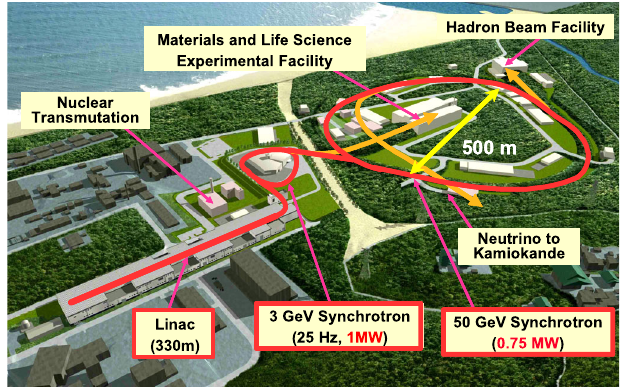
FIG. 1. (Color) Overview of